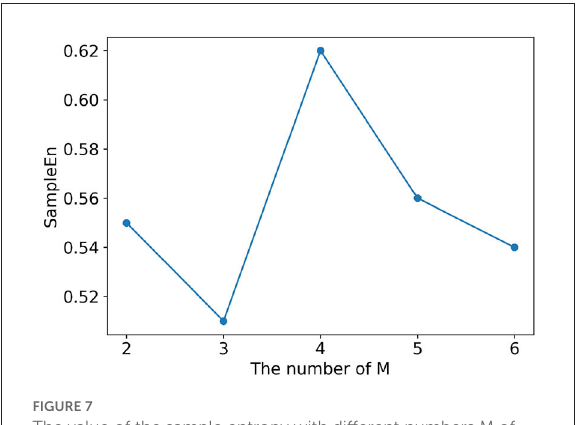
TABLE 2 Parameters of MobileViT for cottonseed with slight crack.